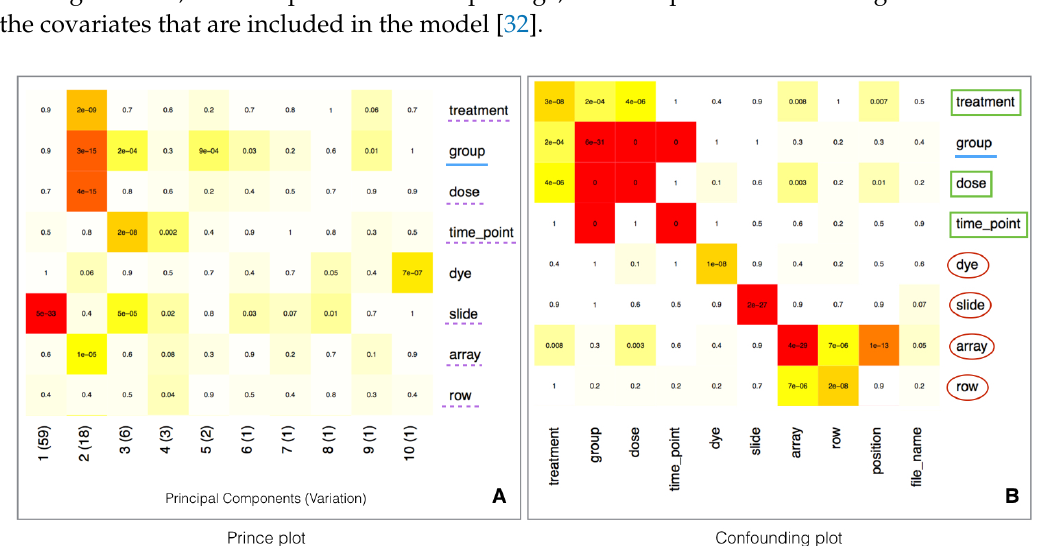
Figure 2. Panel A —Prince plot showing the association between the technical variables and the principal components. The text and the background color in each cell represent the association p -value. The row label underlined with solid blue line represents the variable of interest. The row labels underlined with dotted purple line represent other sources of high variation. Panel B —Confounding plot, representing the correlation among the technical variables. The row label underlined with solid blue line represents the variable of interest. The green squares represent the variables confounded with the variable of interest or other batch variables. The row labels circled by red outline are batch variables suitable for